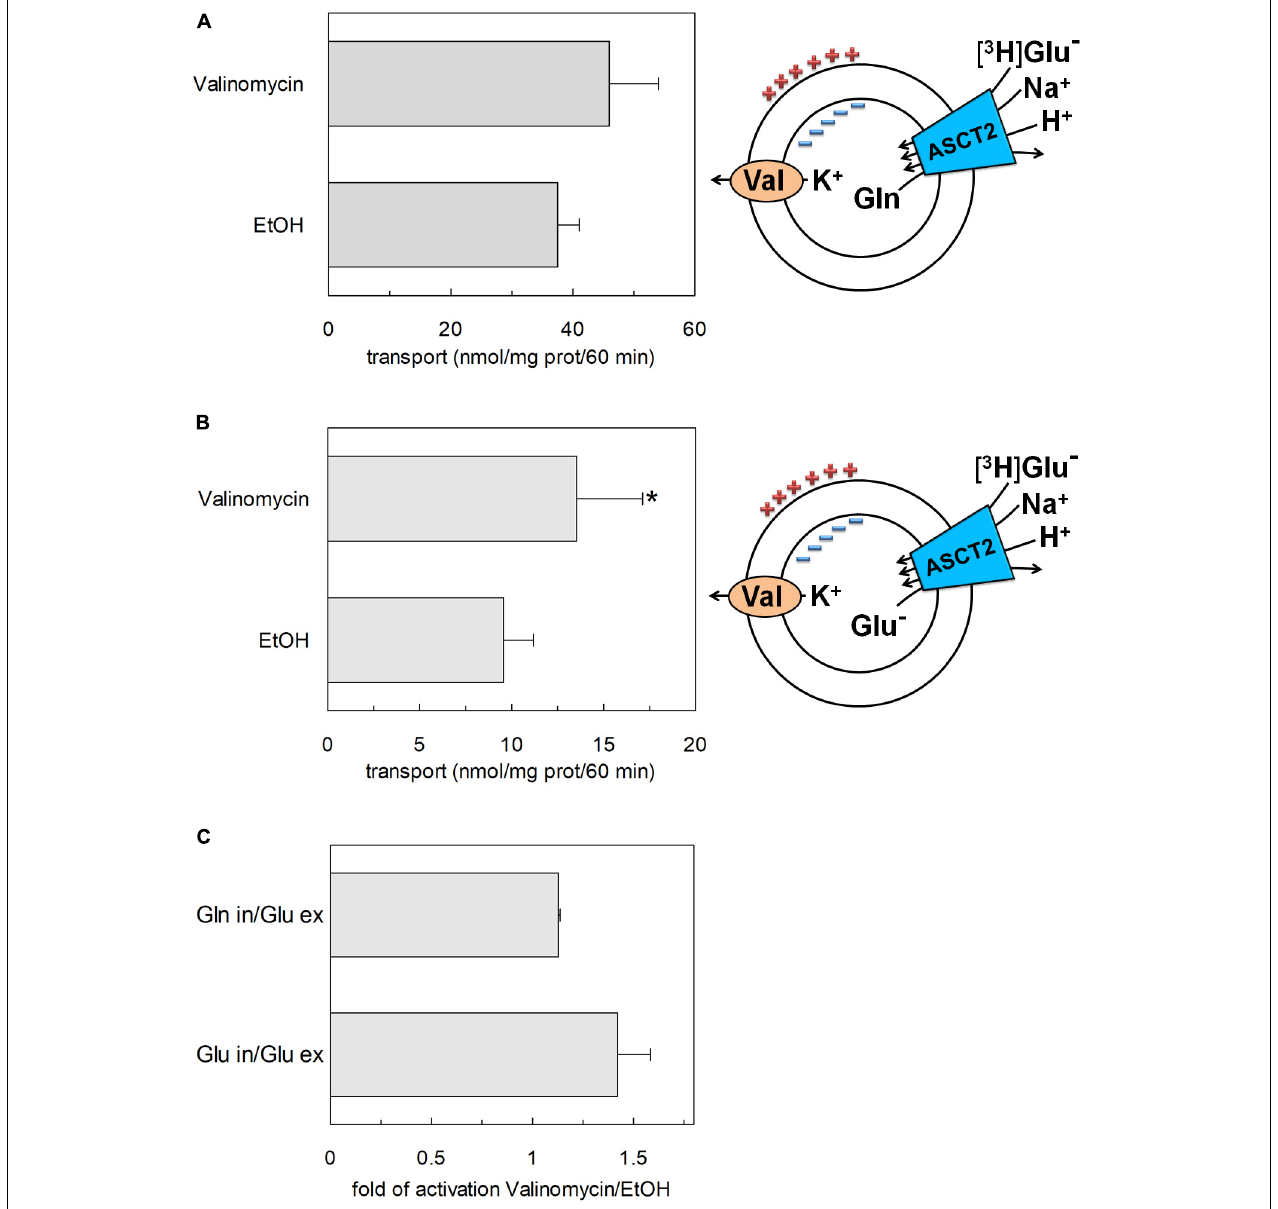
FIGURE 4 | Effect of imposed membrane potential on glutamate transport by hASCT2 reconstituted in proteoliposomes. Purified hASCT2 was reconstituted in proteoliposomes as described in materials and methods. After sephadex-G75 chromatography, proteoliposomes were treated with valinomycin (0.75 µ g/mg phospholipid) to impose the artificial membrane potential. The vehicle of valinomycin, ethanol (EtOH) was used as control of valinomycin treatment. The transport assay was started adding 500 µ M of [ 3 H]glutamate together with 50 mM Na-gluconate to proteoliposomes containing 10 mM glutamine (A) or glutamate (B) and 50 mM K-gluconate. The transport was measured in 60 min according to the stop inhibitor method. The transport rate was expressed as nmol/mg in 60 min. In (A,B) sketch of the experimental set up (proteoliposomes); Val: valinomycin. In (C) , data from (A,B) were used to calculate the fold of activation valinomycin/ethanol. Results are means ± SD from four independent experiments. *Significantly different from the control sample (EtOH) as estimated by Student’s t -test ( P <